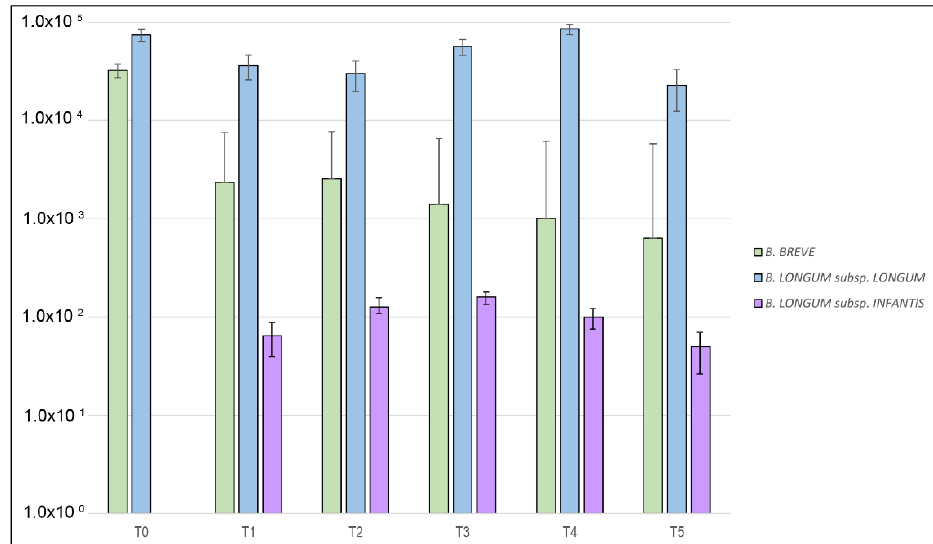
Figure 2. Median differences between B. breve , B. longum subsp. longum and B. longum subsp. infantis levels expressed as molecules/ul at each point of the time-course for the cow’s milk allergic (CMA) group.